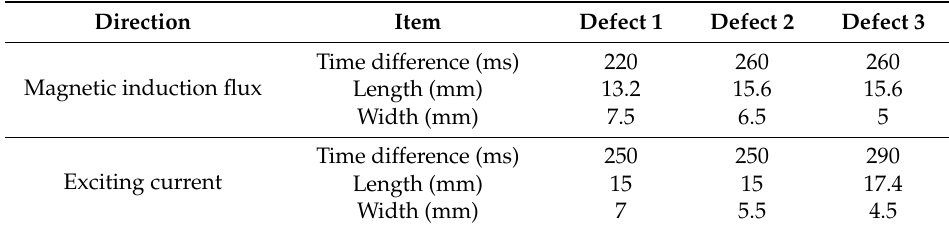
Table 2. Estimated length and